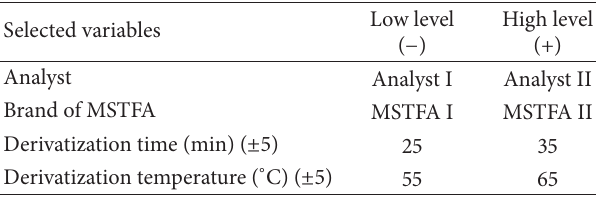
Table 1: Selected method parameters and their levels for Plackett- Burman experimental design.